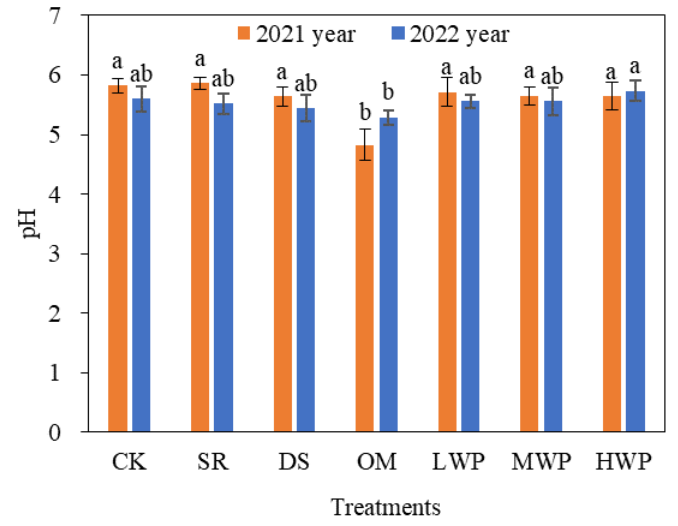
Figure 4. Changes in soil pH under different treatments. Different lowercase letters in the box denote significant differences between different treatments of the same year at p < 0.05, respectively.